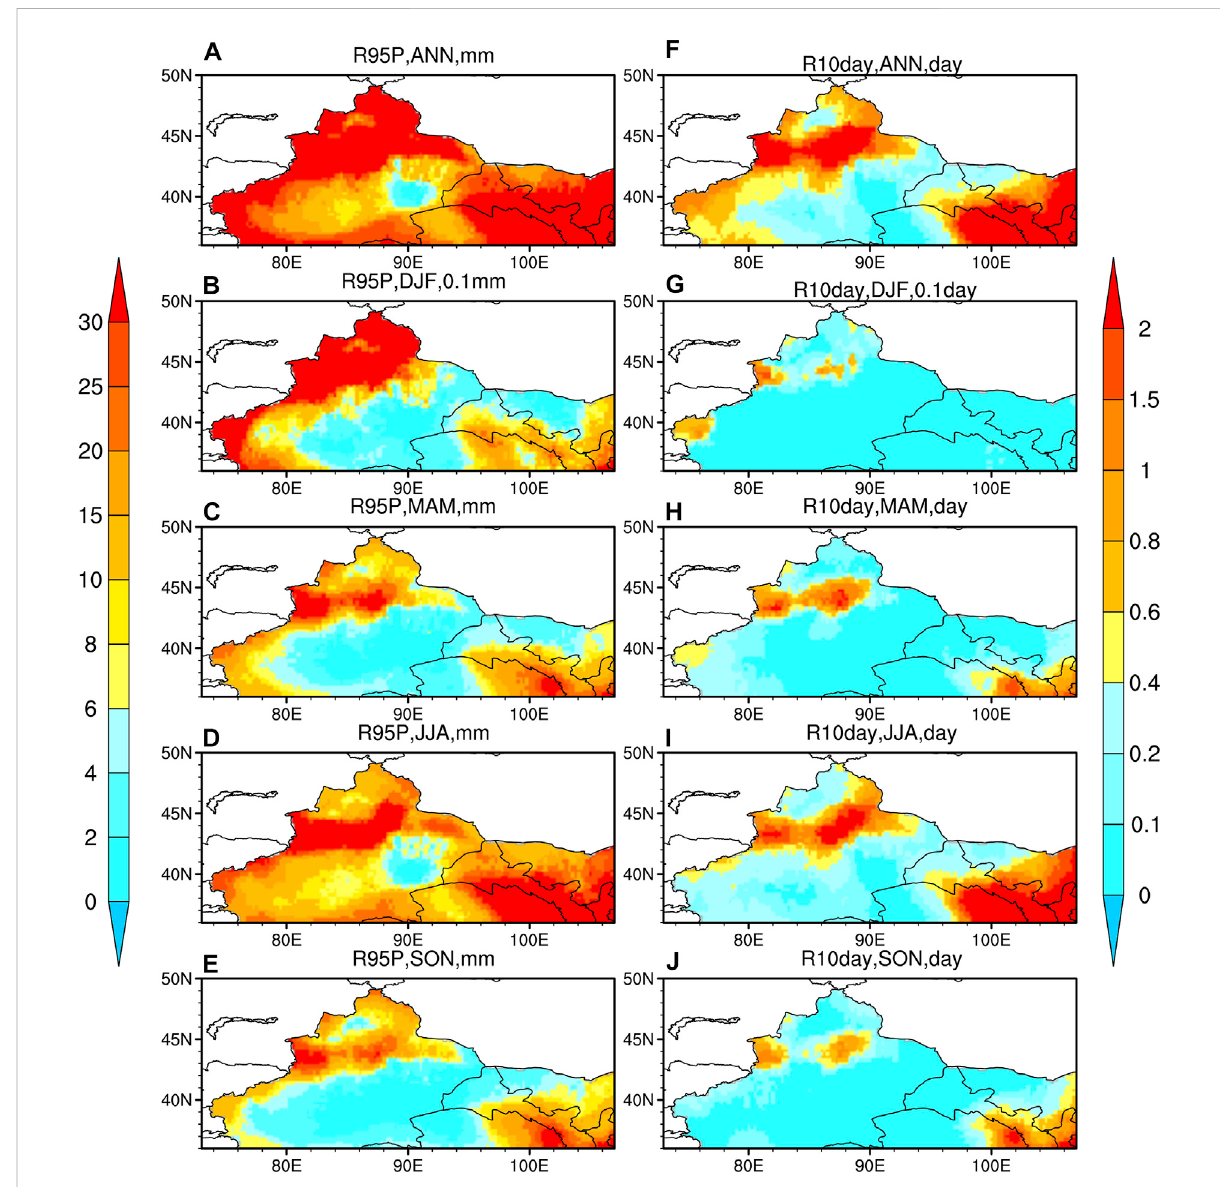
FIGURE 2 SpatialdistributionsofannualandseasonalR95P (A – E) andR10day (F – J) intheANWCduring1961 – 2018.Theremainingunitsaredayandmm, except the units in winter (B,G) , which are 0.1 day and 0.1 mm,